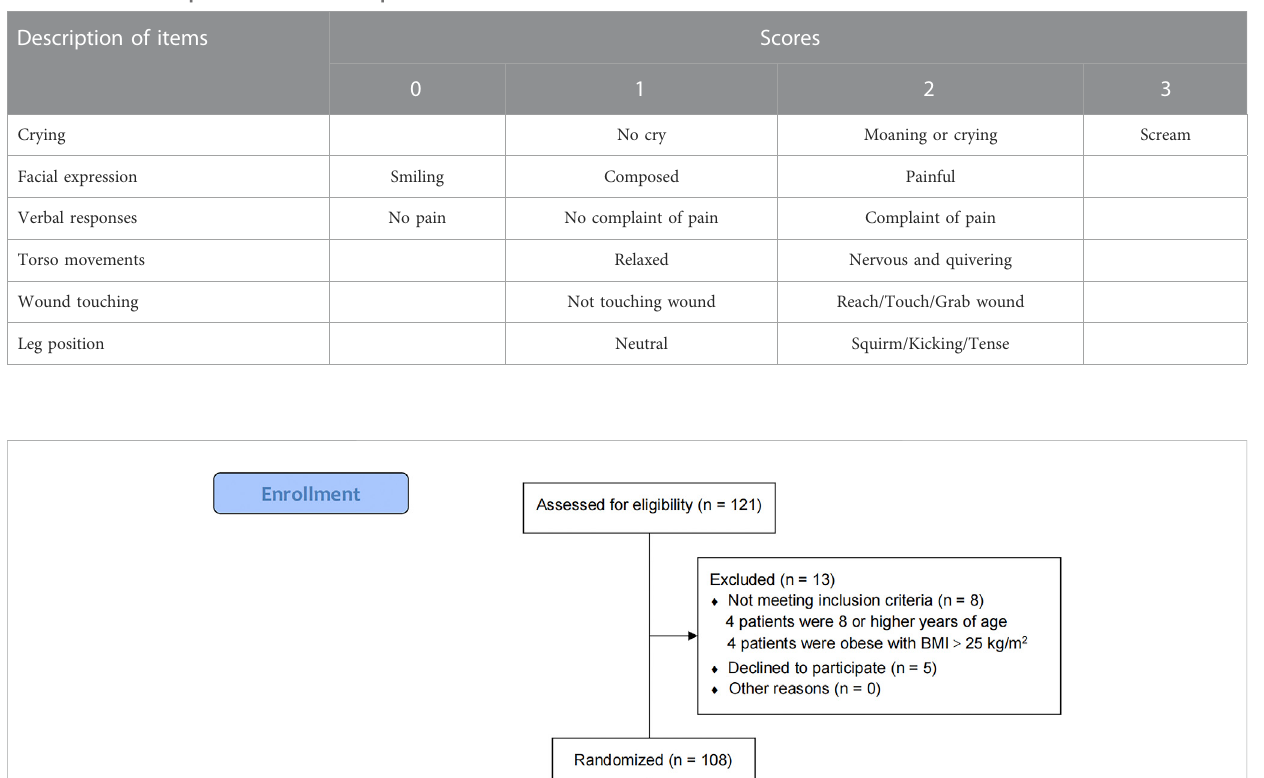
TABLE 2 Children ’ s hospital of eastern Ontario pain scale.